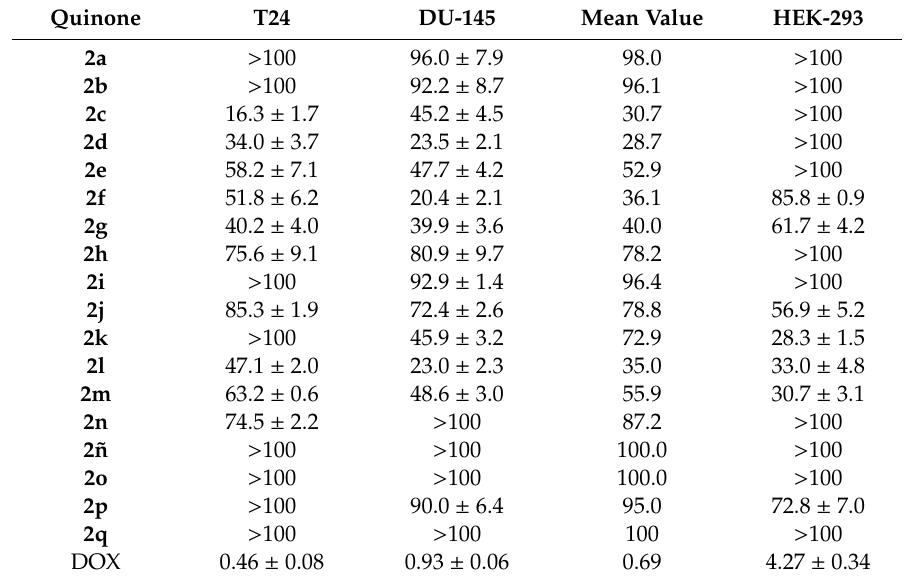
Table 2. IC 50 ± SEM ( µ M) values of 2a – q on T24 (bladder), DU-145 (prostate), and HEK-293 kidney cells. Quinone T24 DU-145 Mean Value HEK-293 2a > 100 96.0 ± 7.9